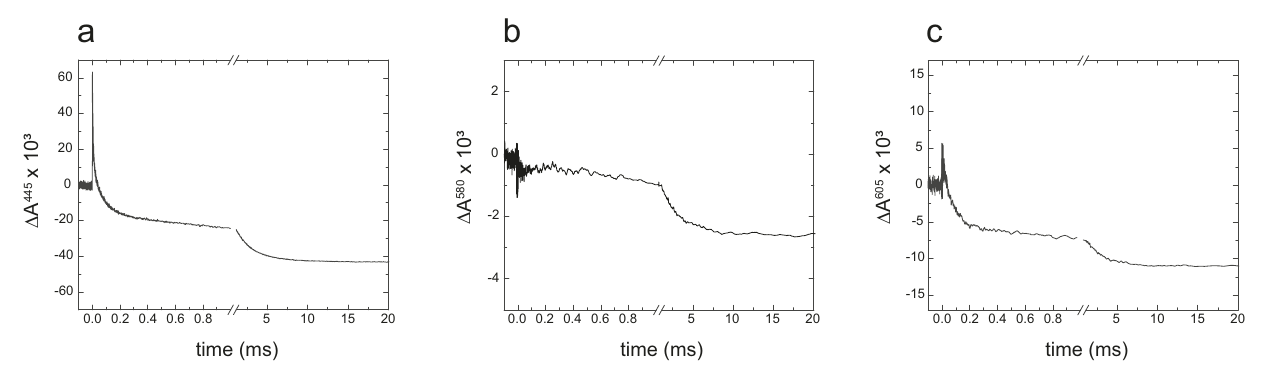
Fig. 5 Reaction of reduced CIV with O 2 . Absorbance changes after fl ash photolysis of CO from the fully reduced CIV after mixing with O 2 (at t = -200 ms) and fl ash photolysis of CO (at t = 0), measured at 445 nm ( a ), 580 nm ( b ) and 605 nm ( c ). Experimental conditions: 25 mM KH 2 PO 4 , pH 7.5, 150 mM KCl, 0.1 mM EDTA, 0.05 % DDM, 0.85 mM O 2 , 1.4 µ M CIV. Laser artifacts due to the laser fl ash hitting the detector at t = 0 have been truncated. The data are averages over 3 (panels a and c ) or 13 (panel b ) traces. These averages were smoothed by averaging over a window of fi ve points. All traces are scaled to 1 µ M reacting enzyme.